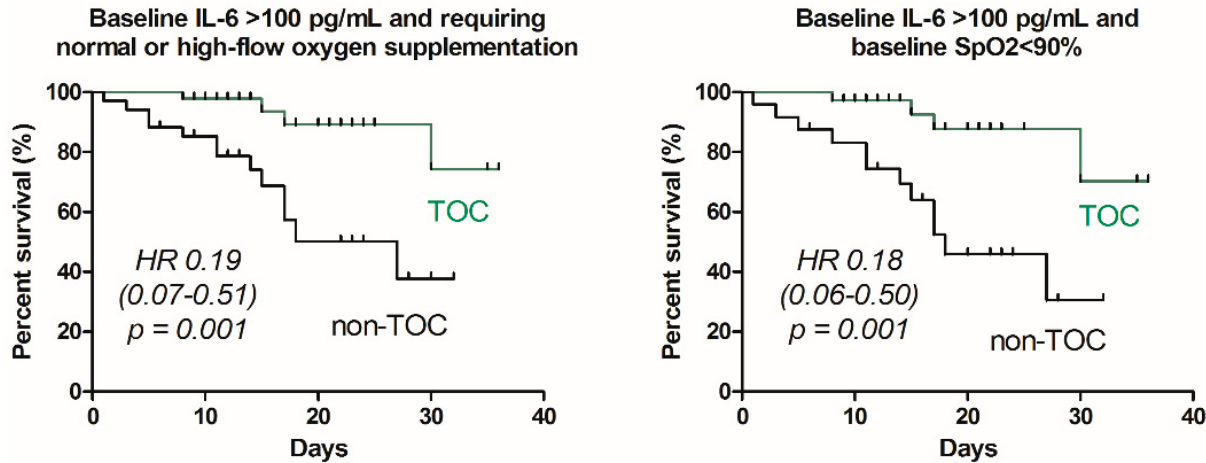
Figure 2. Kaplan–Meier graphs demonstrating the effect of tocilizumab versus no tocilizumab administration on patients’ survival depending on baseline serum concentration of interleukin 6. The hazard ratios (HR) and their 95% confidence intervals are provided as well as the log-rank test p -values.